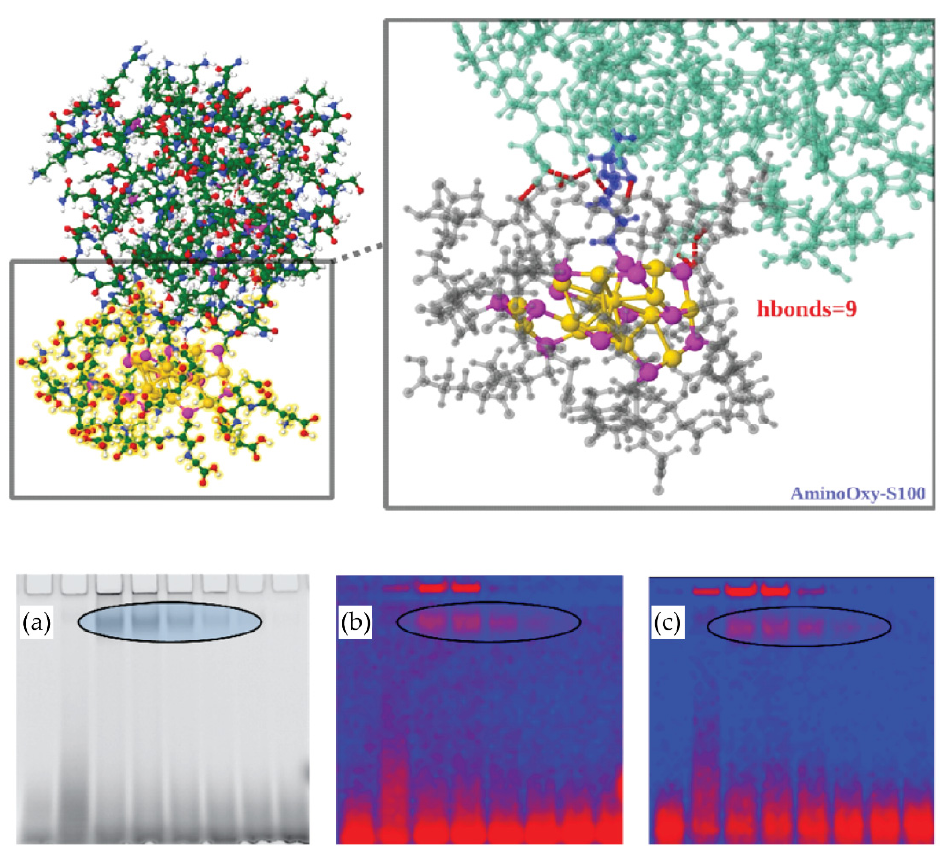
Figure 6. Detection of protein carbonyls using aminooxy-liganded AuNCs (top panel). Quantum mechanics/molecular mechanics (QM/MM) (two-layer ONIOM [174]) interacting with lysozyme. The interface between liganded cluster Au 15 (SG) 12 (3-(aminooxy)-1-propanethiol)1 and protein is enlarged (right side), illustrating the aminooxy-serine oxyme bond and the hydrogen-bonding network (SG—grey; Au—gold; S—magenta; lysozyme—green; oxyme bond—blue; h-bonds—dotted in red). Figure adapted from [167] (bottom panel). Au15-targeted carbonylated proteins detected on gels by fluorescence scanner ( a ) and multiphoton confocal imaging ( b , c ). Laser excitation was at 780 nm, and emitted photons were detected with ( b ) visible range (350–700 nm) and ( c ) IR range (>850 nm). Ellipses: Fixed concentration of 500 µM Au 15 (SG) 12 (3-(aminooxy)-1-propanethiol)1 was incubated with a decreasing range of concentrations of the lysozyme (50–1 µM, corresponding to 5–0.1 µg protein loaded in the gel).